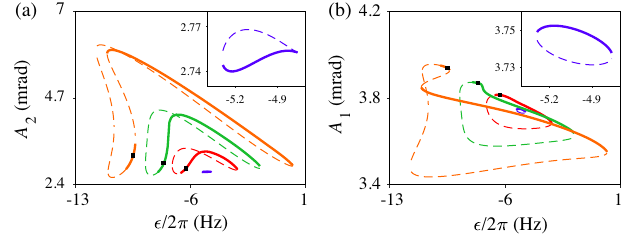
FIG. 6. (a) Amplitude A 2 of mode 2 as a function of the frequency detune ϵ of the drive on mode 2 for pump voltages of 5.54 (blue lines), 6 (red lines), 7 (green lines), and 10 mV (orange lines). Stable and unstable solutions to Eq. (3) with _ u 1 ¼ _ u 2 ¼ 0 are plotted as solid and dashed lines, respectively. The black squares illustrate one way to access the lower branch for a pump voltage of 10 mV: ϵ is adjusted lower as the drive amplitude is increased. (b) Corresponding vibration amplitude for the period- tripled vibrations in mode 1. Insets: enlargement of a pump voltage of 5.54 mV. Solutions for zero vibration amplitude for mode 1 are omitted in both